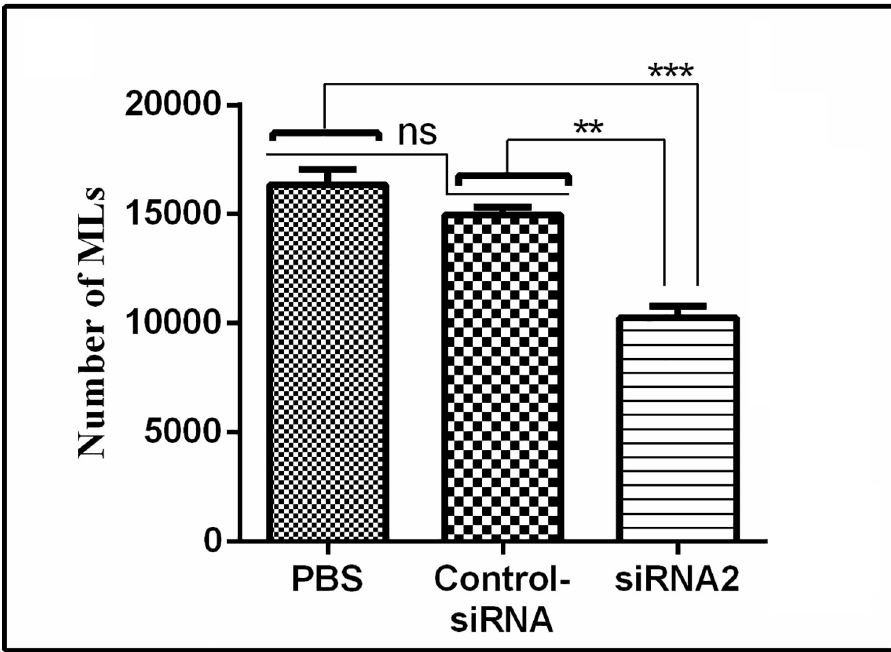
Fig 8. Infectivity of siRNA2 treated NBL. Number of ML population developed from siRNA2 treated NBLs. The significant level was set at �� P < 0.01, ��� P < 0.001, and ns non-significant compared with control group.